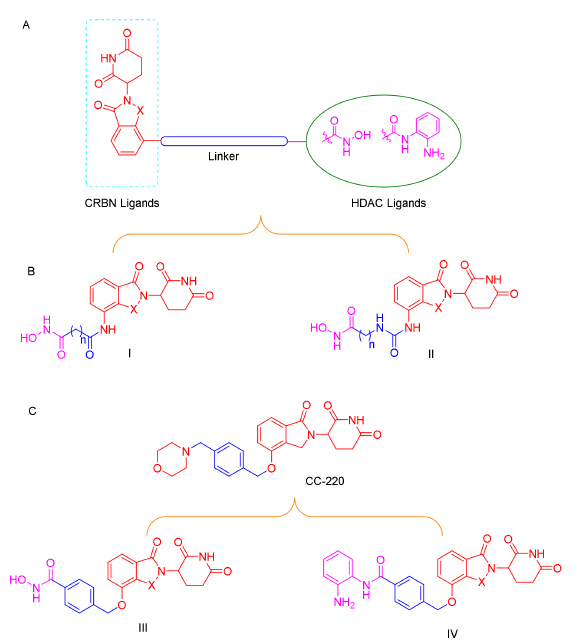
Figure 3. ( A ) Conceptual PROTAC design for targeting HDACs; ( B ) design of the typical HDAC PROTACs; ( C ) CC-220 structure-based HDAC